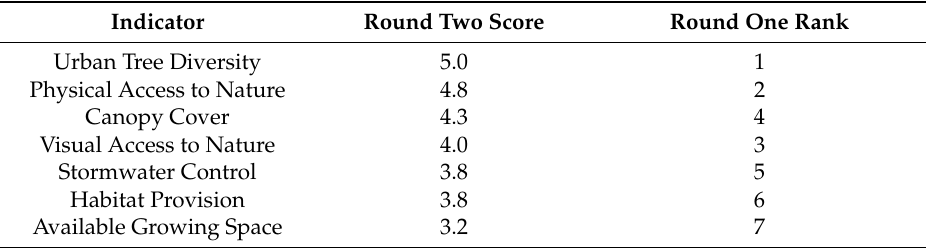
Table 3. Academic consensus after Round Two.